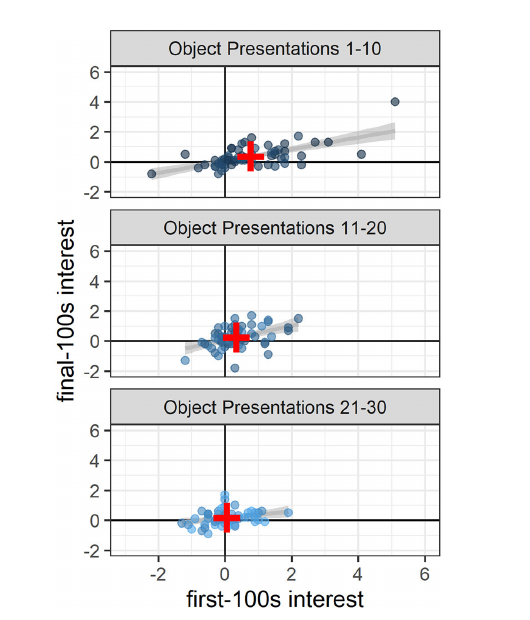
FIGURE3 Sustained interest across the 10min of novel object presentations. Throughout the study, high interest in the first 100s generally corresponded to high interest in the final 100s of the 10-min novel object presentations (presentations 1–10: p < 0.0001; presentations 11–20: p < 0.001; presentations 21–30 p < 0.02). Dots indicate the number of fish in the object area above the average number of fish in the object area during baseline and are colored according to object presentation order (dark blue: 1–10; medium blue: 11–20; light blue: 21–30). Gray lines and shaded areas represent the best linear fit and its 95% Confidence Interval. Red plus symbols indicate the center of each bivariate distribution (see online version for color).